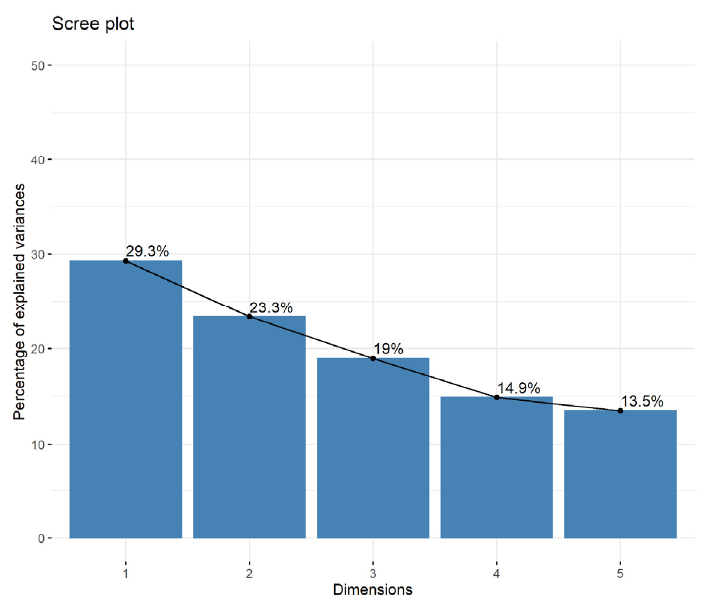
Figure A1. Eigenvalues of factors or principal components in an analysis.